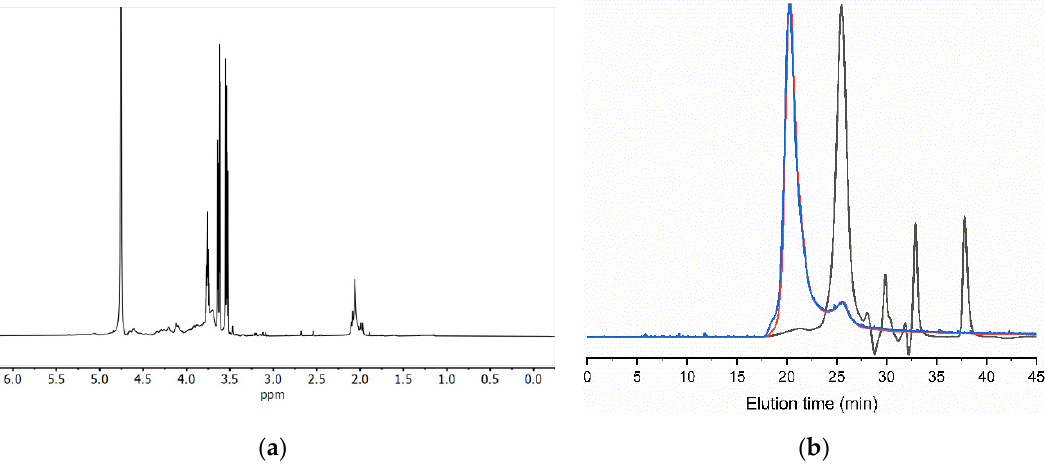
Figure 5. The 1 H NMR ( a ) and GPC eluogram ( b ) of the unfractionated tunic polysaccharides. Black trace: refractive index detector (RID); red trace: right ‐ angle light scattering detector (RALS); and blue trace: low ‐ angle light scattering detector (LALS).